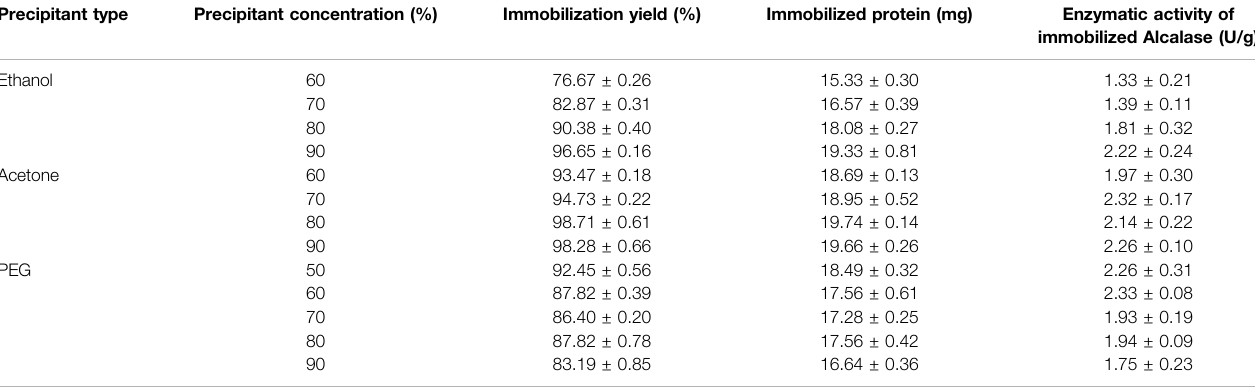
TABLE 1 | Immobilization performance of Alcalase ® -CLEAs at different precipitant conditions. Precipitant type Precipitant concentration